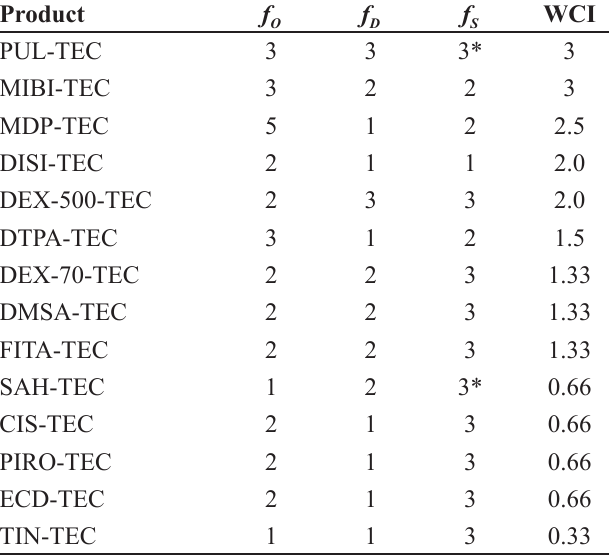
TABLE VI - Values of factors f each LR manufactured at IPEN-CNEN/São